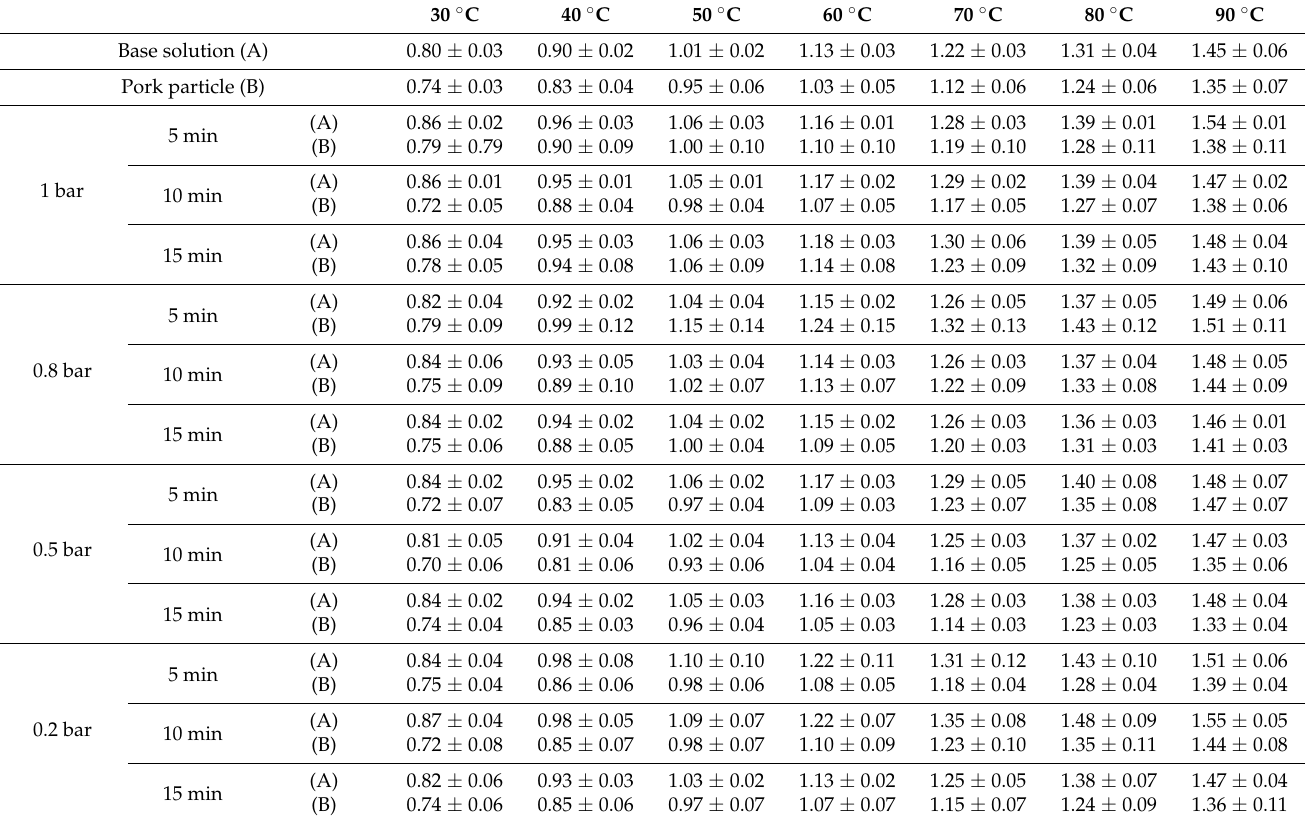
Table 2. The measured electrical conductivities of pork particle and base solution after vacuum